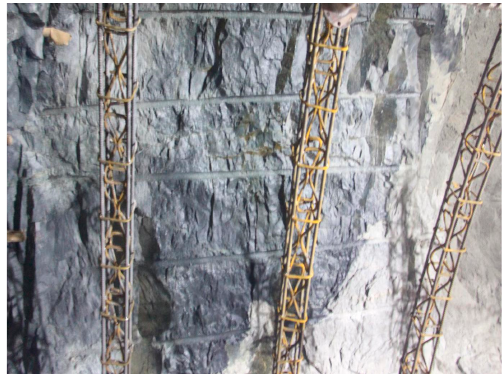
Figure 14. Schematic diagram of practical SWB effect.